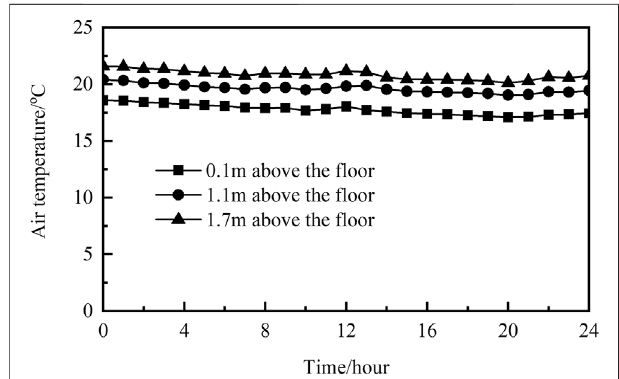
FIGURE 5 | Indoor temperature